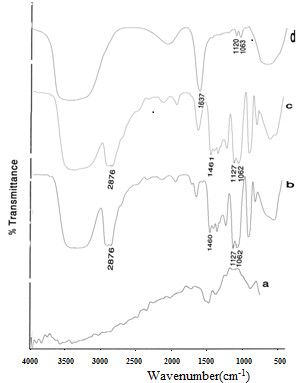
FTIR spectra for DEGcoatings nanoparticles. FTIR spectra of (a) commercial Gd2O3 powder (b) pure DEG. (c) Gd2O3 nanocrystals prepared by DEG coating without dialysis and centrifuge. (d) Gd2O3 nanocrystals prepared by DEG coating after dialysis and centrifuge. Curves (c) and (d) show effects of new synthesis route in chemical composition.